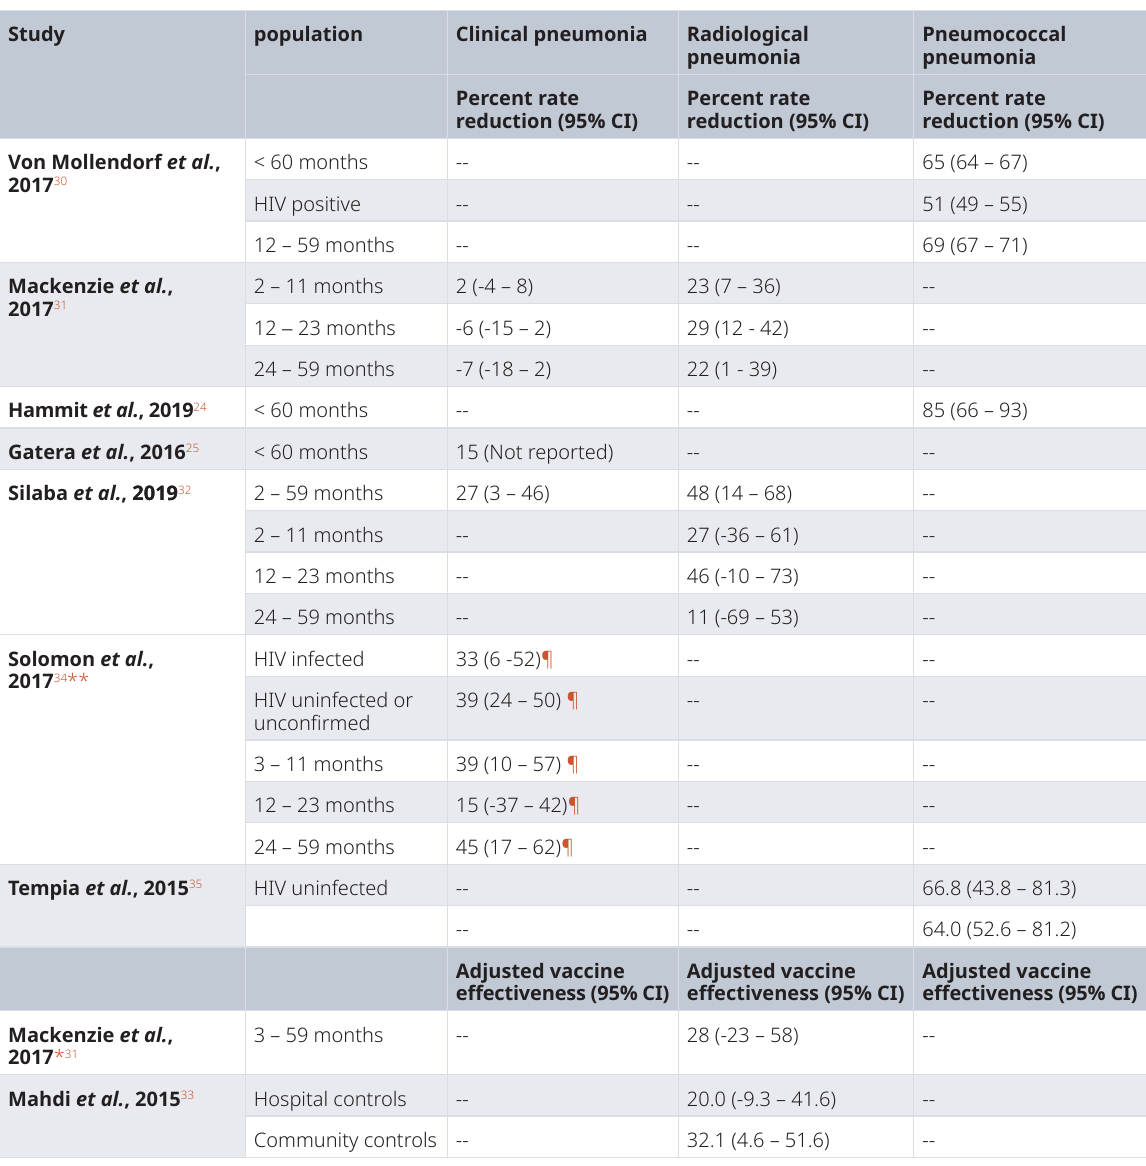
Table 3. Summary of effect reported in studies included in the